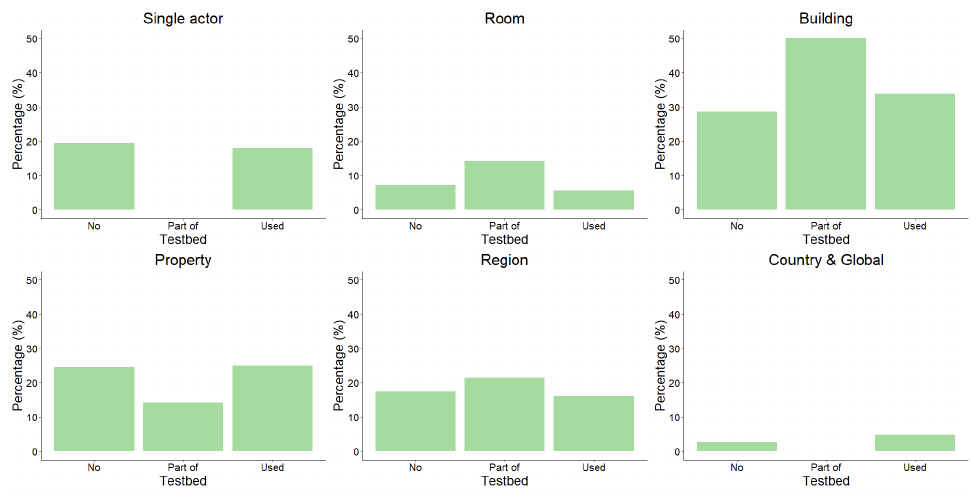
Figure 32. Deployment distribution between usage of testbed facilities and deployment